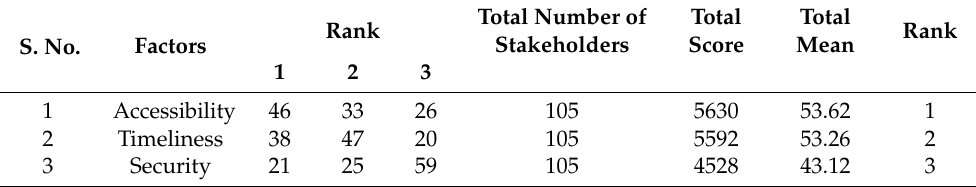
Table 8. Ranking of dimensions within the empiric category of the semiotic framework.